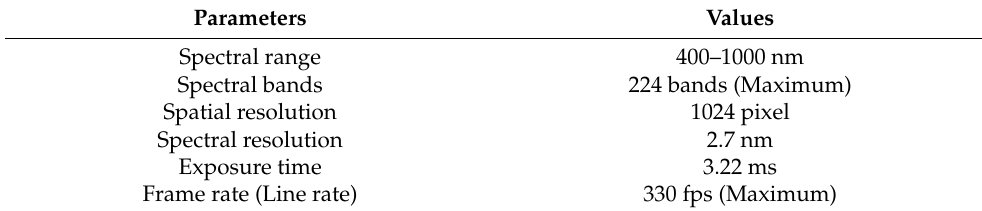
Table 1. Specifications of the FX-10e.